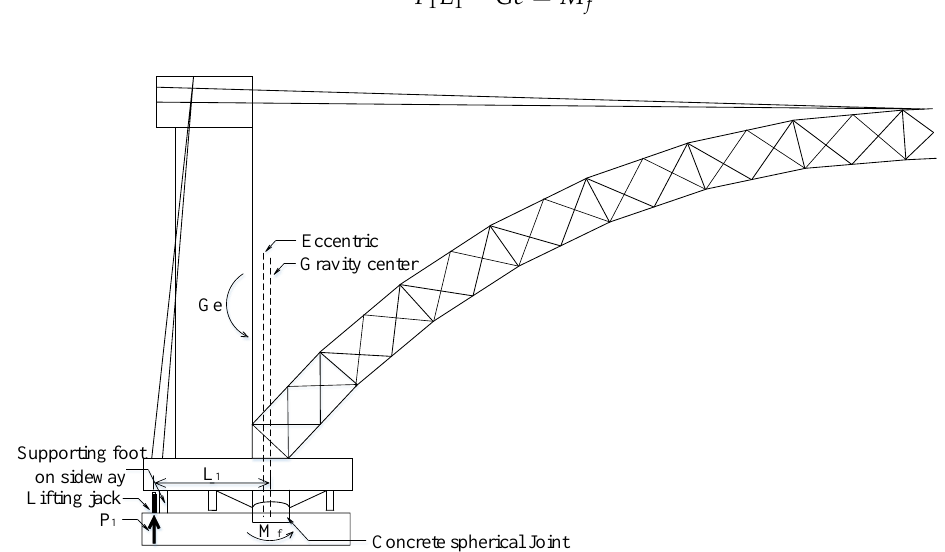
Figure 9. Lifting force on the left side of the rotating system.